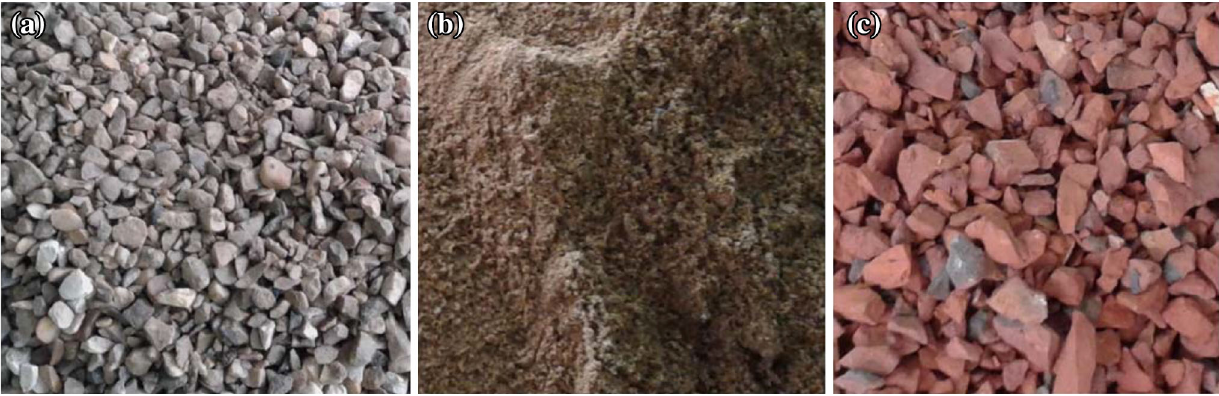
Fig. 1 Aggregates ( a ) stone chips ( b ) sand ( c ) masonry chip aggregate (MCA).